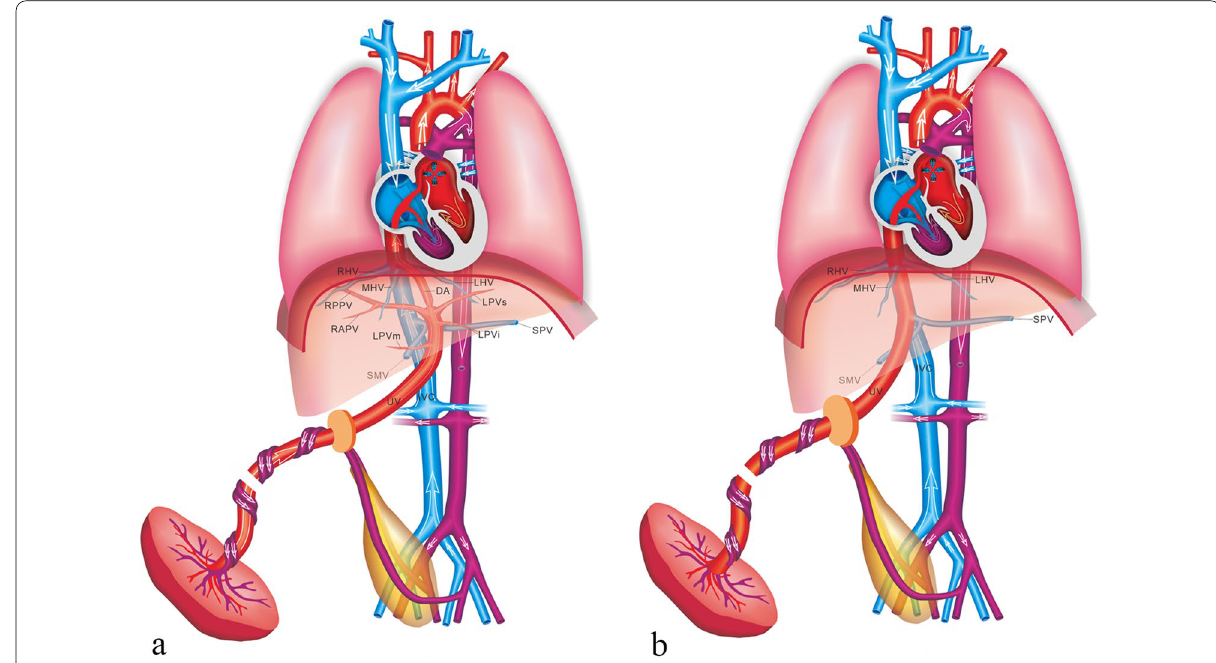
Fig. 14 Schematic drawing of the EHPSS. The MPV drains into the IVC with the IHPVS presence ( a ) and absence ( b